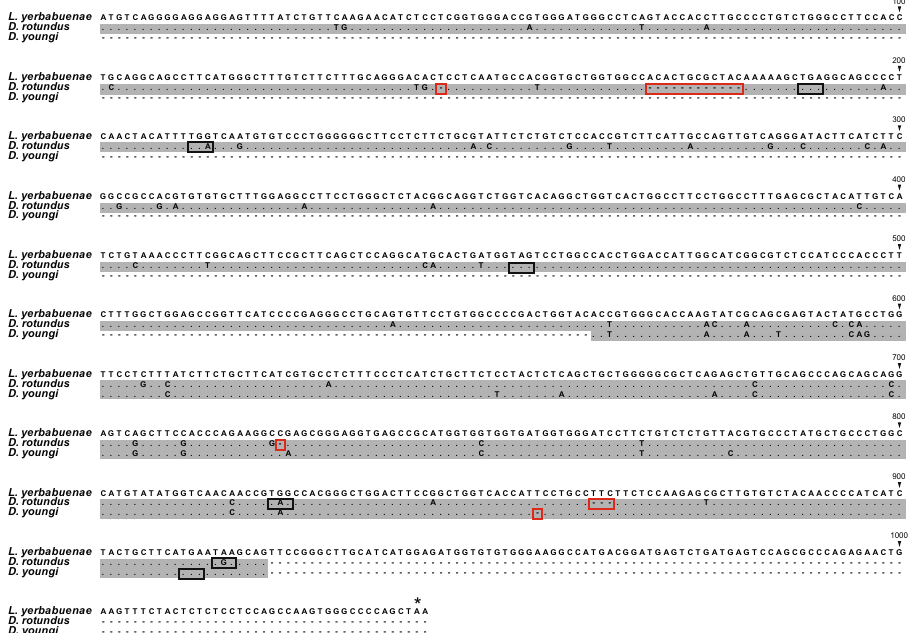
Figure 1. Alignment of vampire bat SWS1 sequences. The nectar-feeding bat Leptonycteris yerbabuenae is a close relative of vampire bats and has an intact SWS1 coding region (“ * ” indicates the stop codon). Numbering of the alignment is according to the full-length L. yerbabuenae sequence. Only partial coding regions were sequenced from the two vampire bats, and are shown with a gray background. Deletion events in the vampire bat sequences are indicated by the red boxes and premature stop codons by the black